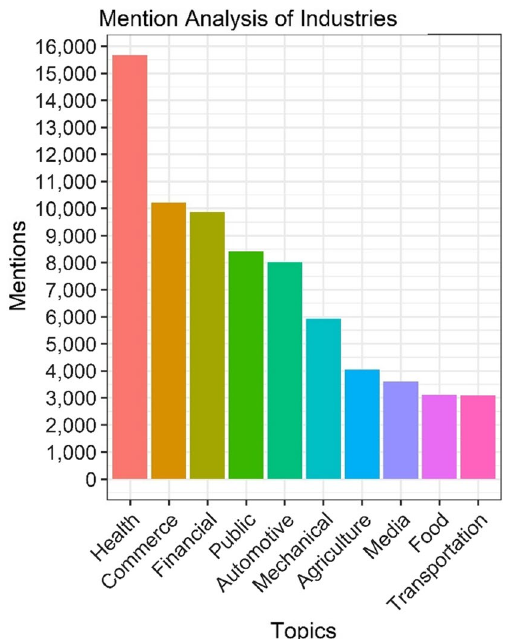
Fig. 7 The top ten mentioned industry within the collection of IoT tweets was healthcare followed by commerce and then